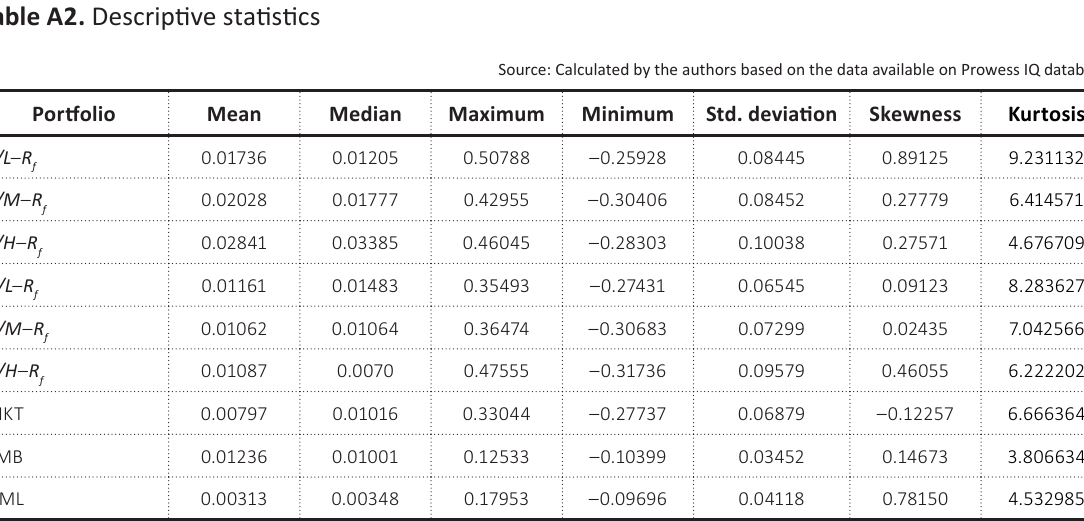
Table A2. Descriptive statistics